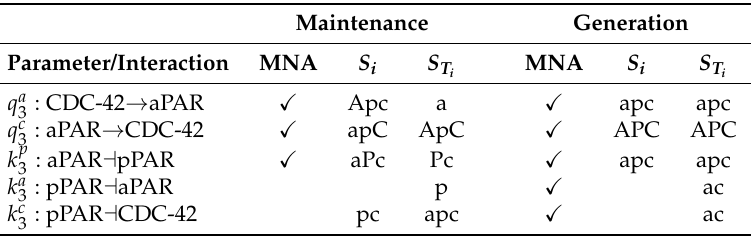
Table 1. Summary of minimal network and sensitivity analyses results. MNA: Minimal Network Analysis, S i : First order index, S T : Total effect index. For MNA, a small checkmark indicates i additional interactions required for pattern generation. For sensitivity measures, a/p/c denote the aPAR/pPAR/CDC-42 sensitivity functions, respectively, and a capital letter indicates the parameter with the highest index for that